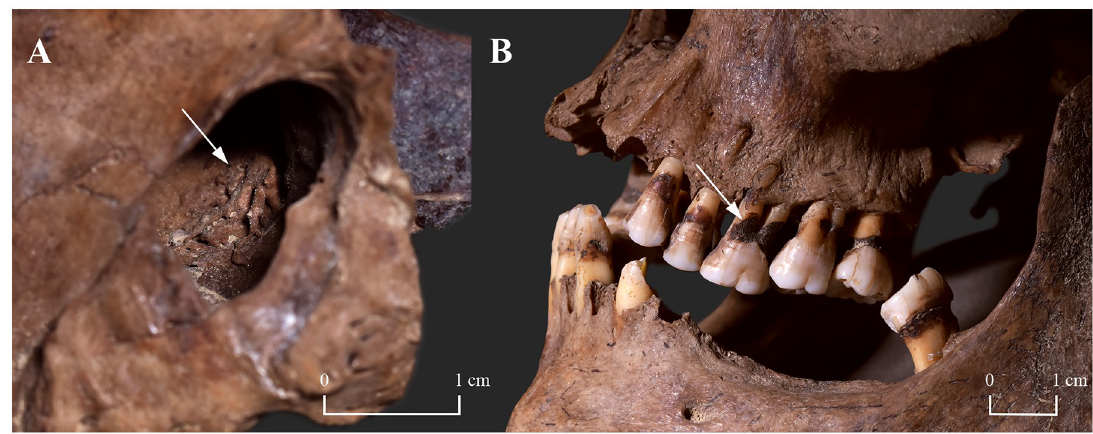
Fig 5. A) Subperiosteal new bone formations in the right maxillary sinus (white arrow) of KD271; and B) signs of caries (white arrow) on the maxillary and mandibular teeth of KD271, and alveolar bone recession of the maxillary teeth of KD271.